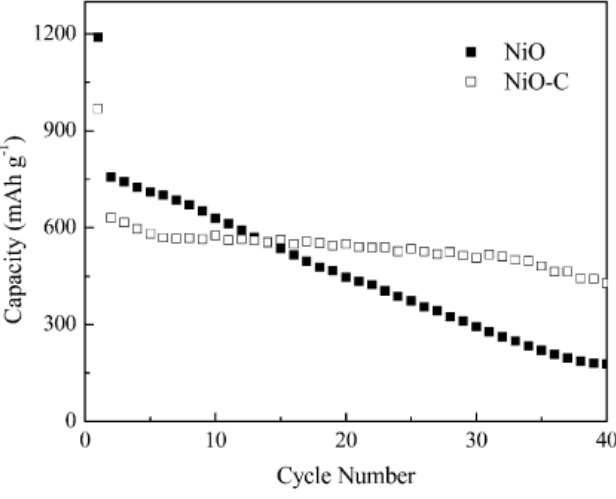
Figure 9. capacity vs. cycle number profiles of the NiO and NiO-C electrodes cycled between 0.02 and 3.0 V at 0.1 C rate. Adapted from [162]. Copyright 2007 the Electrochemical